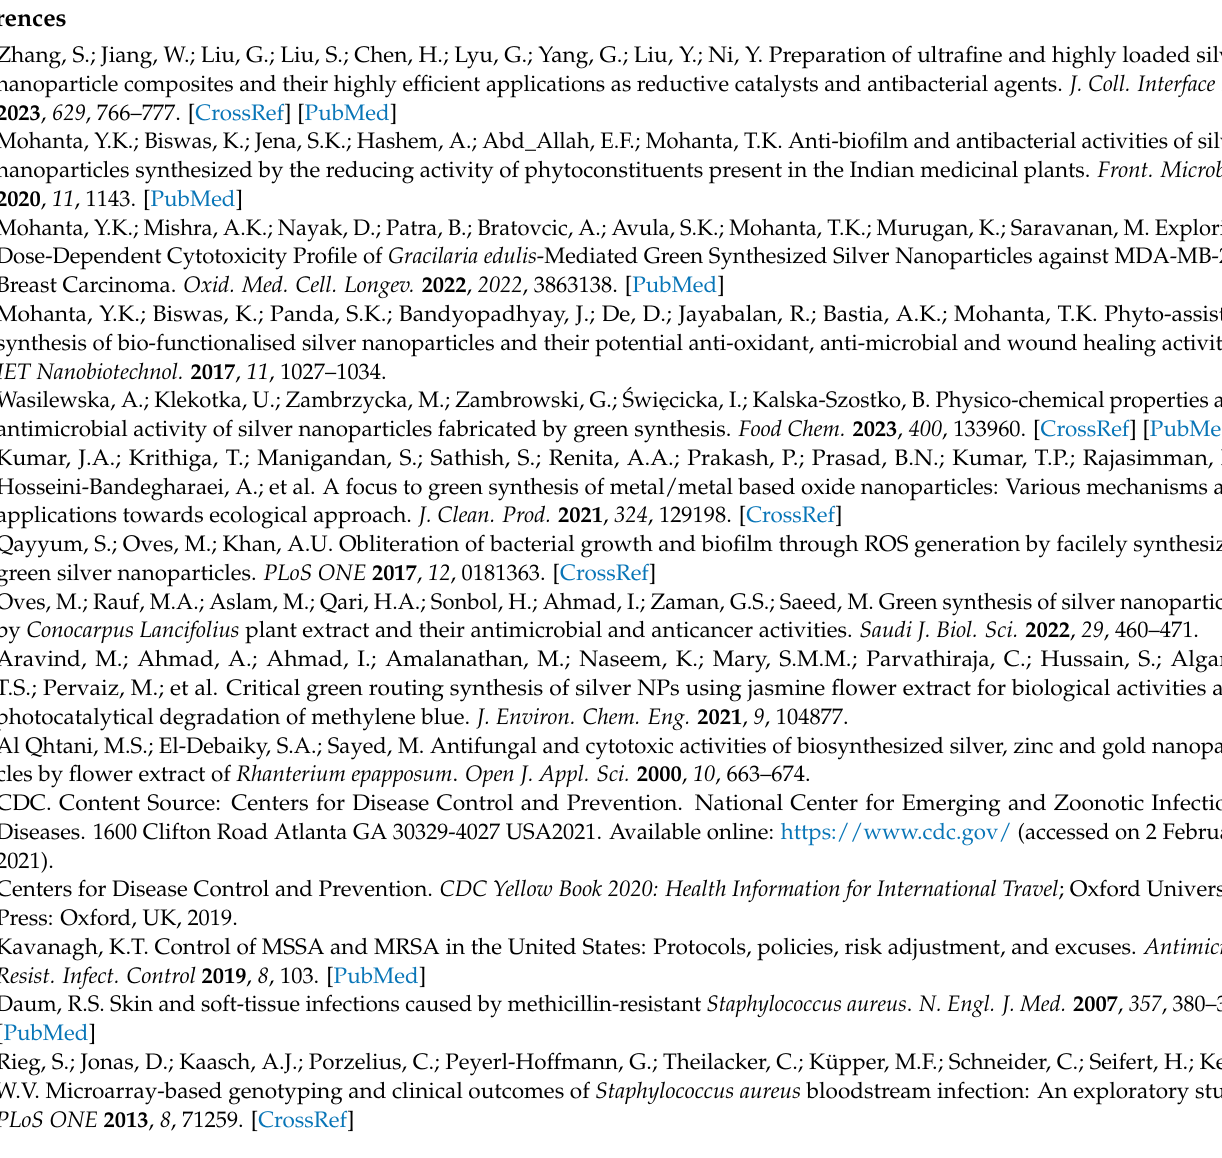
Figure S3. The silver nanomaterials release kinetics when it was filled in a 12 kDa limit dialysis bag submerged in HEPES